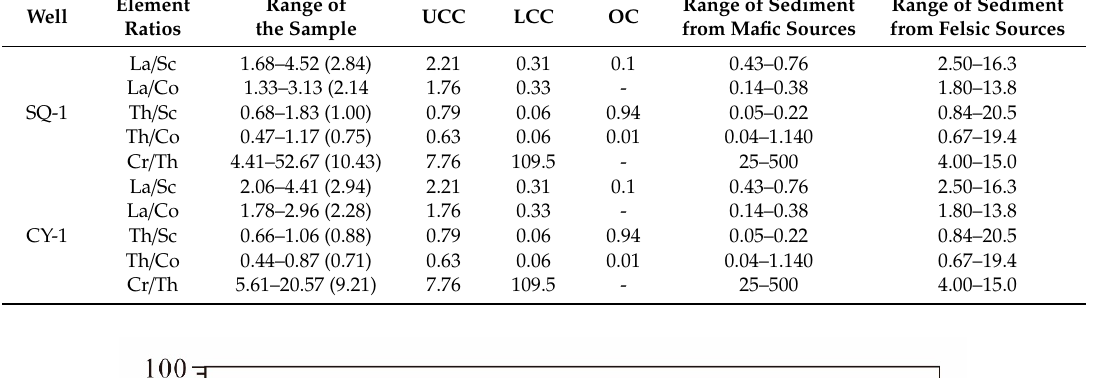
Table 1. Range of several elemental ratios of the samples from the SQ-1 and CY-1 compared with the counterparts in sediments originated from the upper continental crust (UCC), lower continental crust (LCC), oceanic crust (OC), mafic rocks, and felsic rocks.